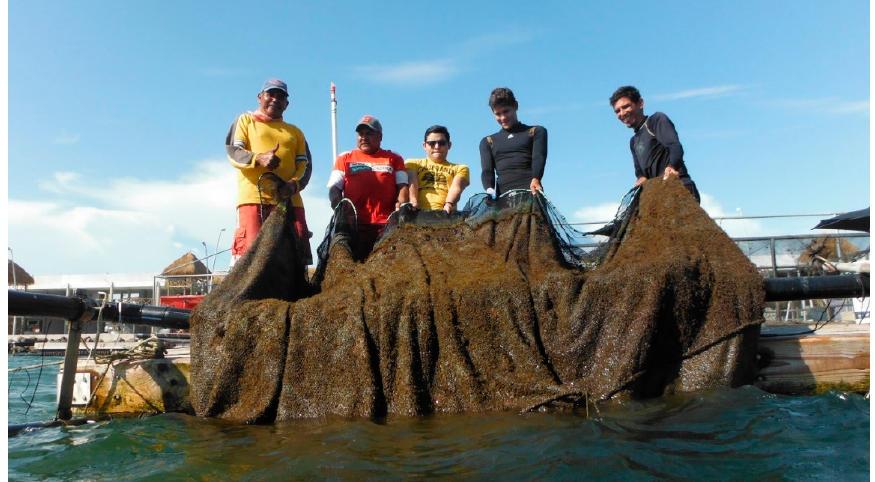
Figure 2. Marine aquaculture cage nets brittle from biofouling, Altata, Sinaloa, Mexico.